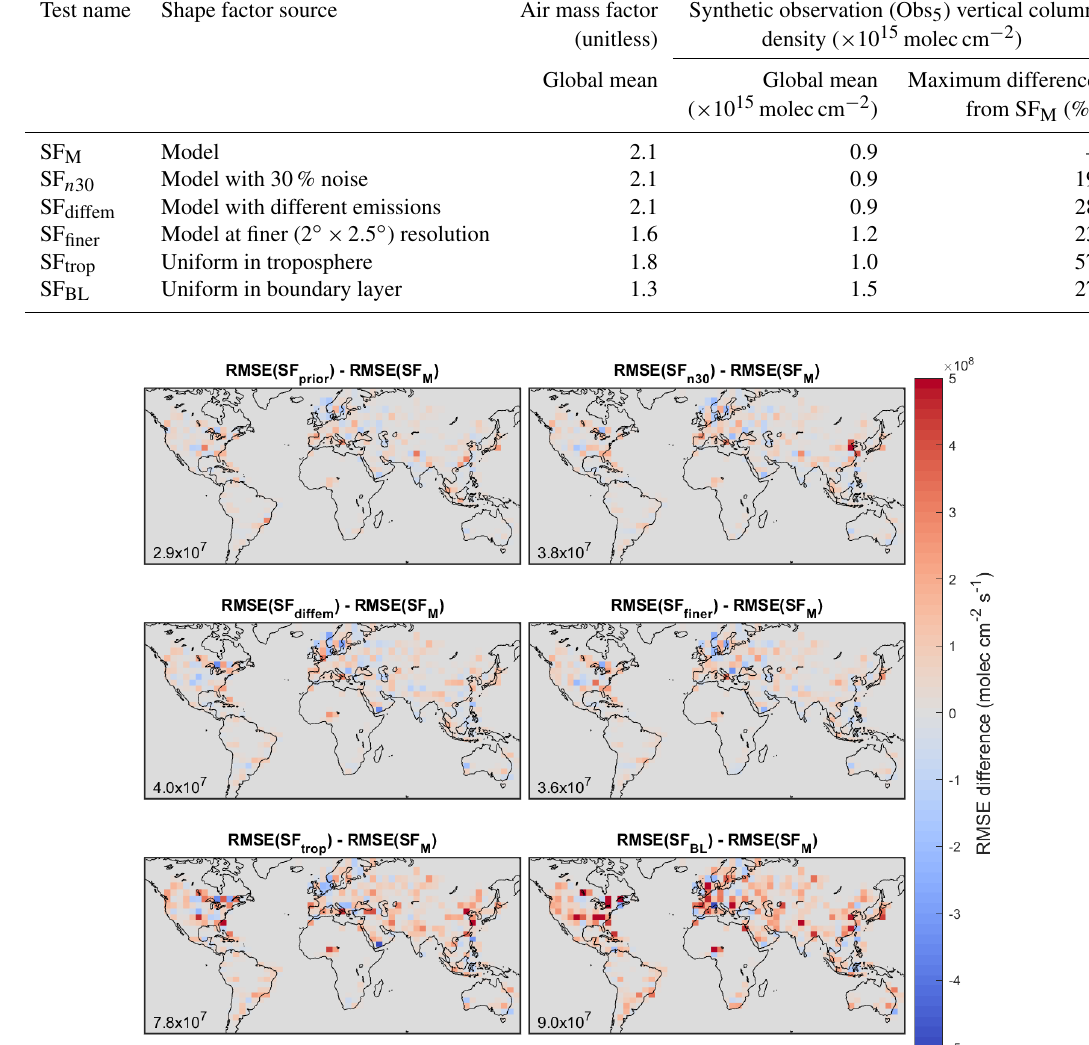
Table 2. Global mean air mass factors and synthetic observation vertical column density for shape factors tested here.